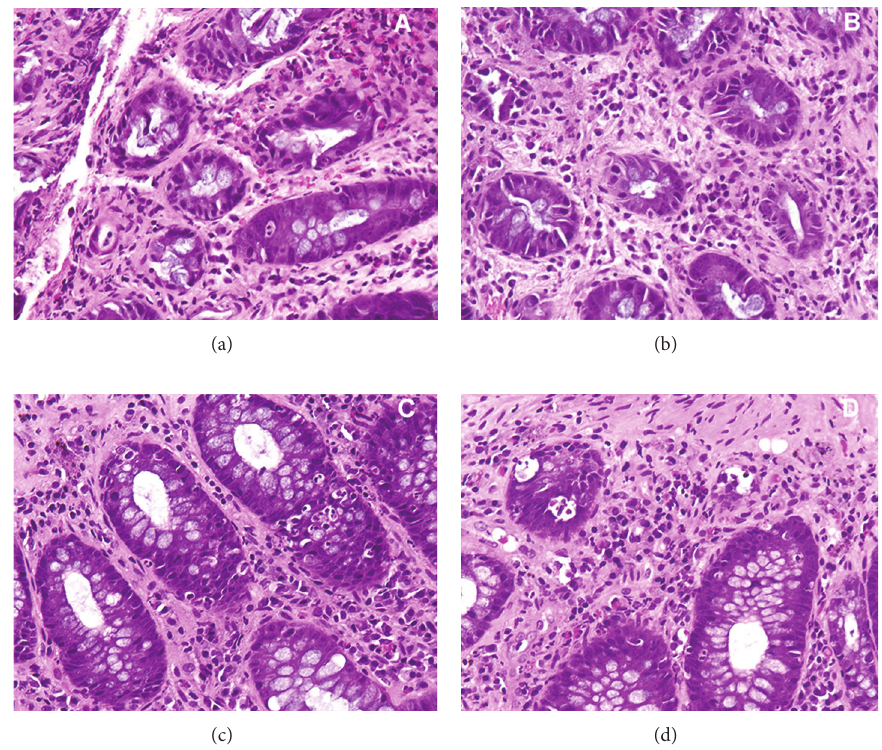
Figure 1: Representative inflammatory epithelial changes in rectal tissue in the early postirradiation period consisting of infiltration of the laminapropriabyneutrophils,cryptitis,andfewcryptabscesses(c,d).Additionalfindingsweremildfocalfibrosis(a–d),mildcryptdistortion, and atrophy (a,